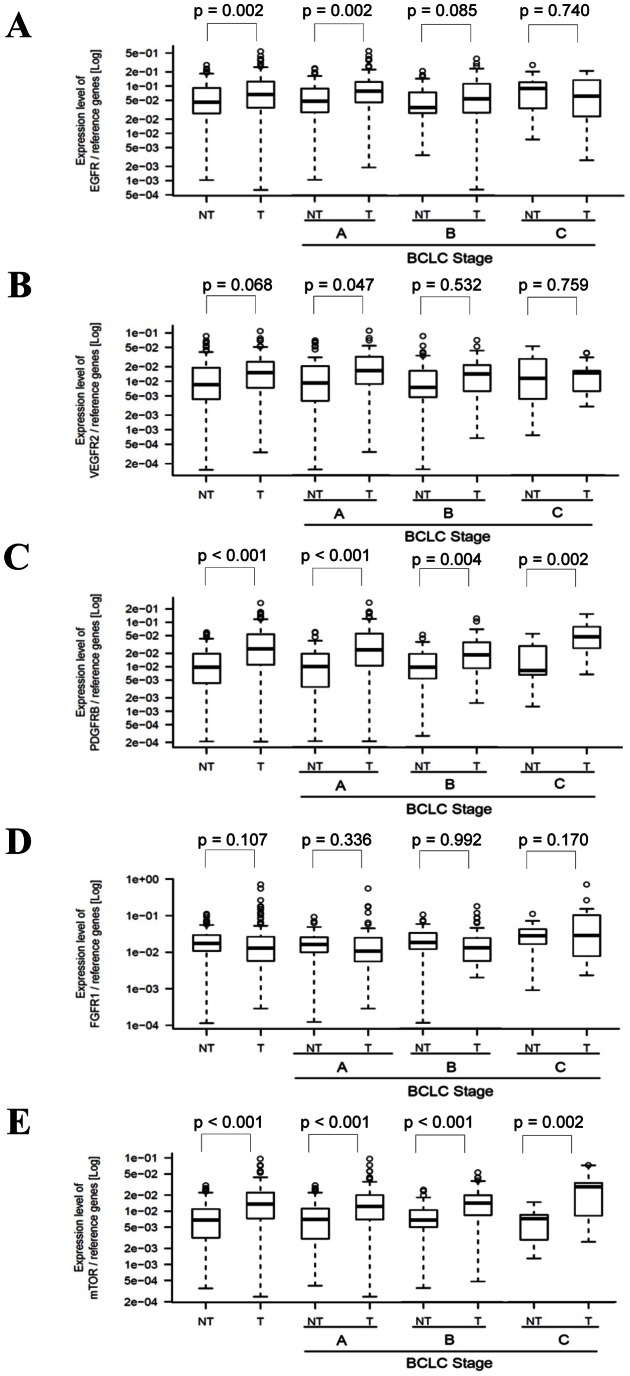
mRNA expression of actionable molecules in HCC patients.Box and whisker plot for expression of EGFR (A), VEGFR2 (B), PDGFRβ (C), FGFR1 (D), and mTOR (E) in non-cancerous hepatic (NT) and matched tumor (T) tissues determined by real-time RT-PCR. The box is marked by the first and third quartile with the median marked by a thick line. The whiskers extend to the most extreme data point which is no more than 1.5 times the interquartile range from the box. A, B, and C: BCLC stage A, B, and C, respectively.